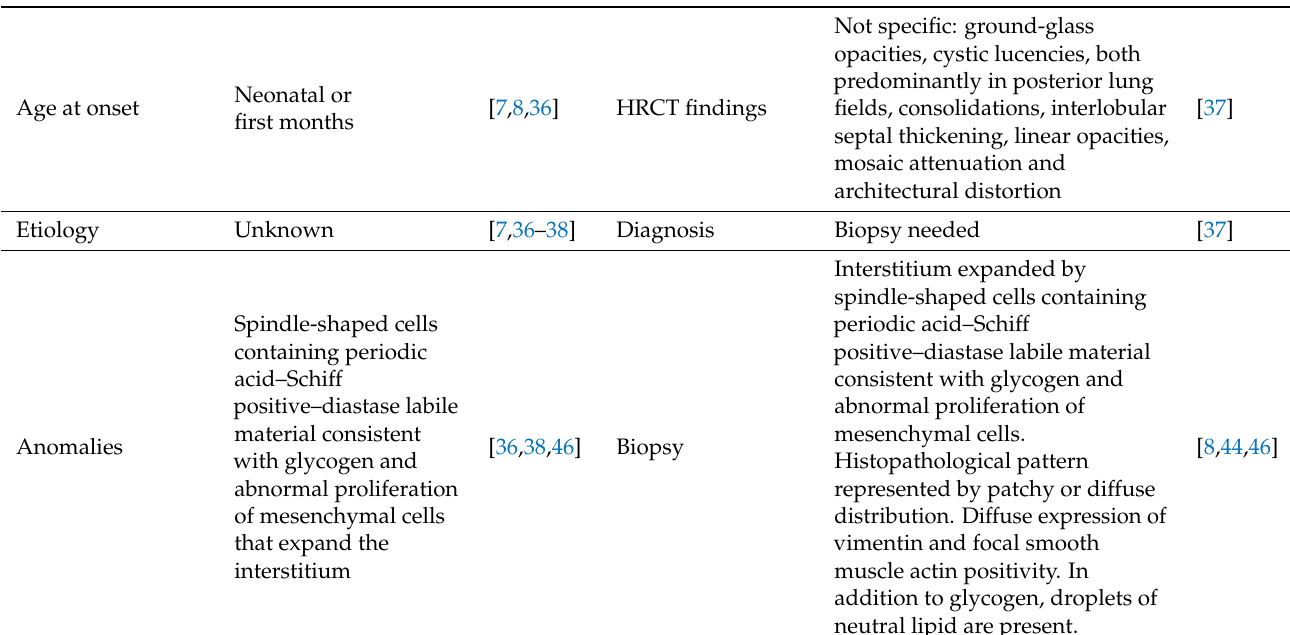
Table 2. PIG main